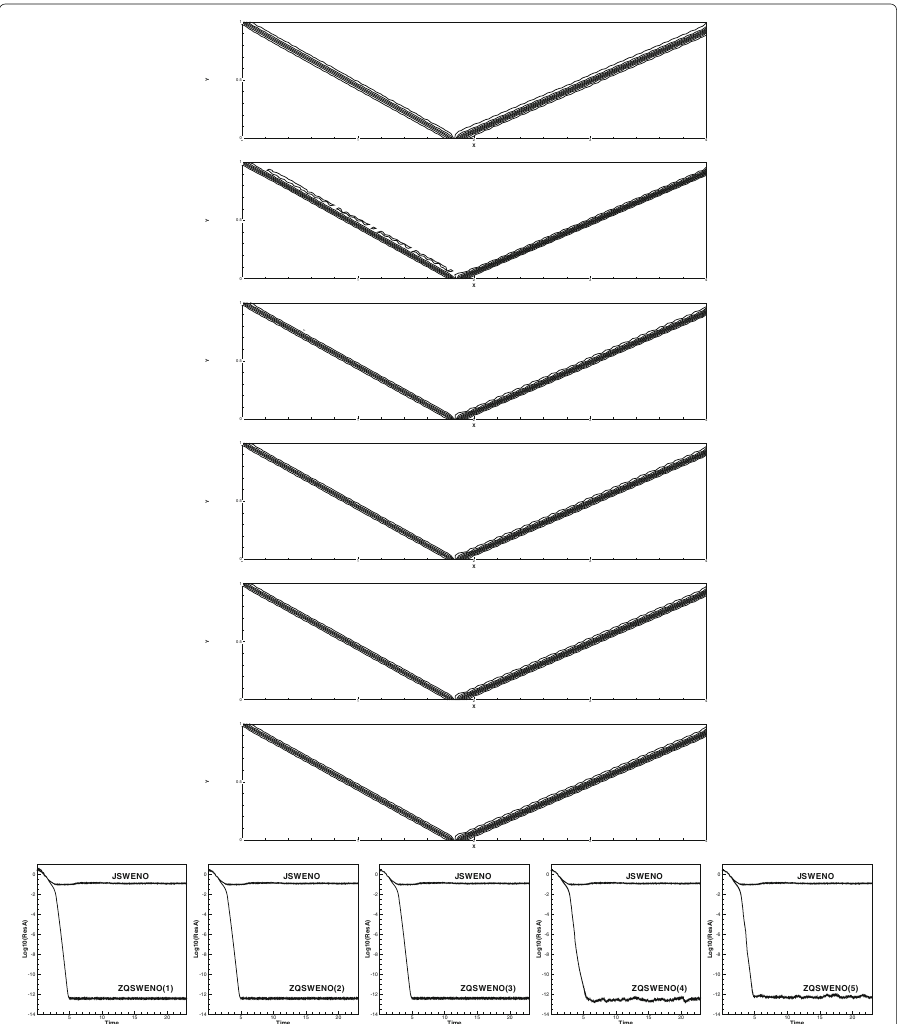
Fig. 10 The shock reflection problem. From top to bottom and left to right: 15 equally spaced density contours from 1.10 to 2.58 of JSWENO scheme; ZQSWENO scheme with (1) ε = 10 − 2 , (2) ε = 10 − 4 , (3) ε = 10 − 6 , (4) ε = 10 − 8 , and (5) ε = 10 − 10 ; the evolution of the average residue. 121 × 31